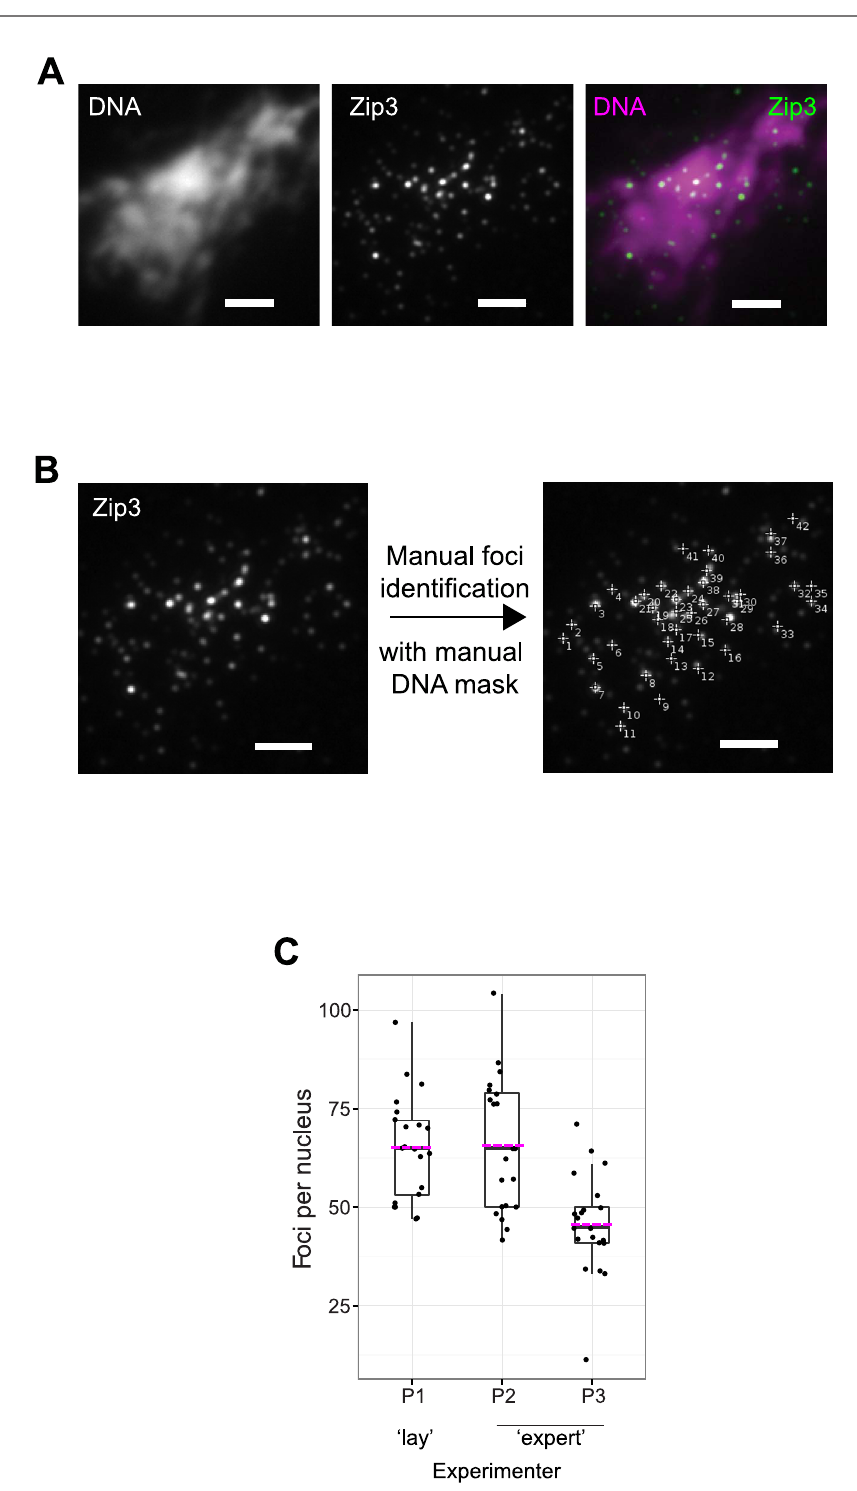
Figure 1. Example image and manual focus identification. (A) Spread nuclear DNA from budding yeast meiosis stained with DAPI (DNA, left) and antibodies against Zip3-GFP (middle). The merged image is shown in false colour on the right. Scale bar 5 2 m m. (B) Experimenter-labelled maxima (foci) of Zip3-GFP within the DNA region (determined by the experimenter). (C) Quantification of foci from the same 21 images by